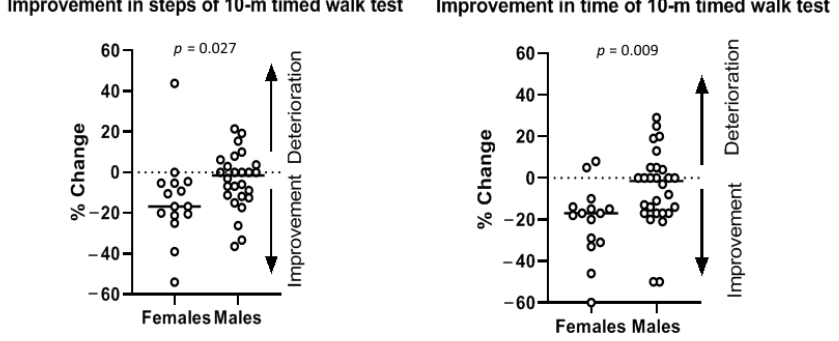
Figure 3. Improvement in steps ( p = 0.027) and in time ( p = 0.009) of 10 m timed walk test differed significantly between female and male patients with iNPH. The horizontal bars represent the median change in steps of 10 m timed walk test during tap test among male and female patients.